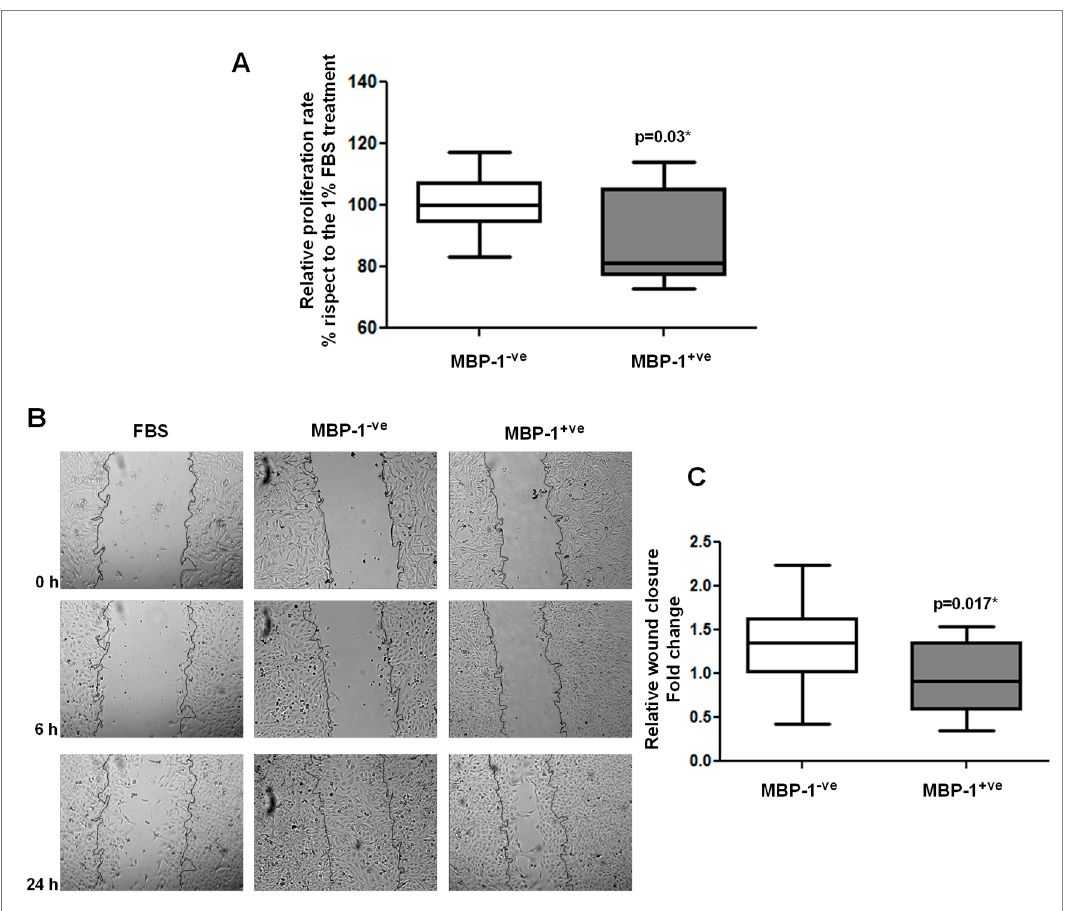
Figure 6. E ff ect of MBP-1 − ve and MBP-1 + ve breast cancer sera on cancer cell proliferation and migration. ( A ) Relative cell growth measured by MTT assay. MDA-MB-231 cells were starved for 24 h (0% FBS) and then treated for 24 h with 1% FBS or 1% of human sera from breast cancer patients, previously grouped as MBP-1 − ve and MBP-1 + ve . ( B ) Wound healing of MDA-MB-231 cells after stimulation with 1% of FBS and 1% of human sera from breast cancer patients, previously grouped as MBP-1 -ve and MBP-1 + ve . Migration at the edge of the scratch was analyzed at 0, 6 and 24 h (magnification, 100 × ). ( C ) Quantification of cell migration was performed measuring the scratch wound, and results are expressed relative to the closure of 1% FBS treatment.